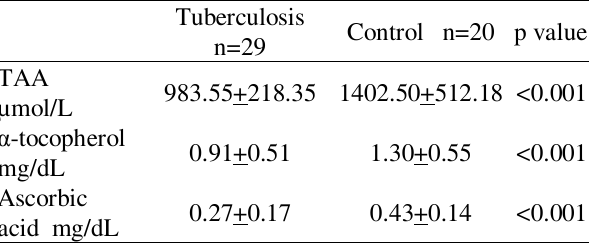
Table 7: Total antioxidant, ascorbic acid, and α -tocopherol levels in tuberculosis.